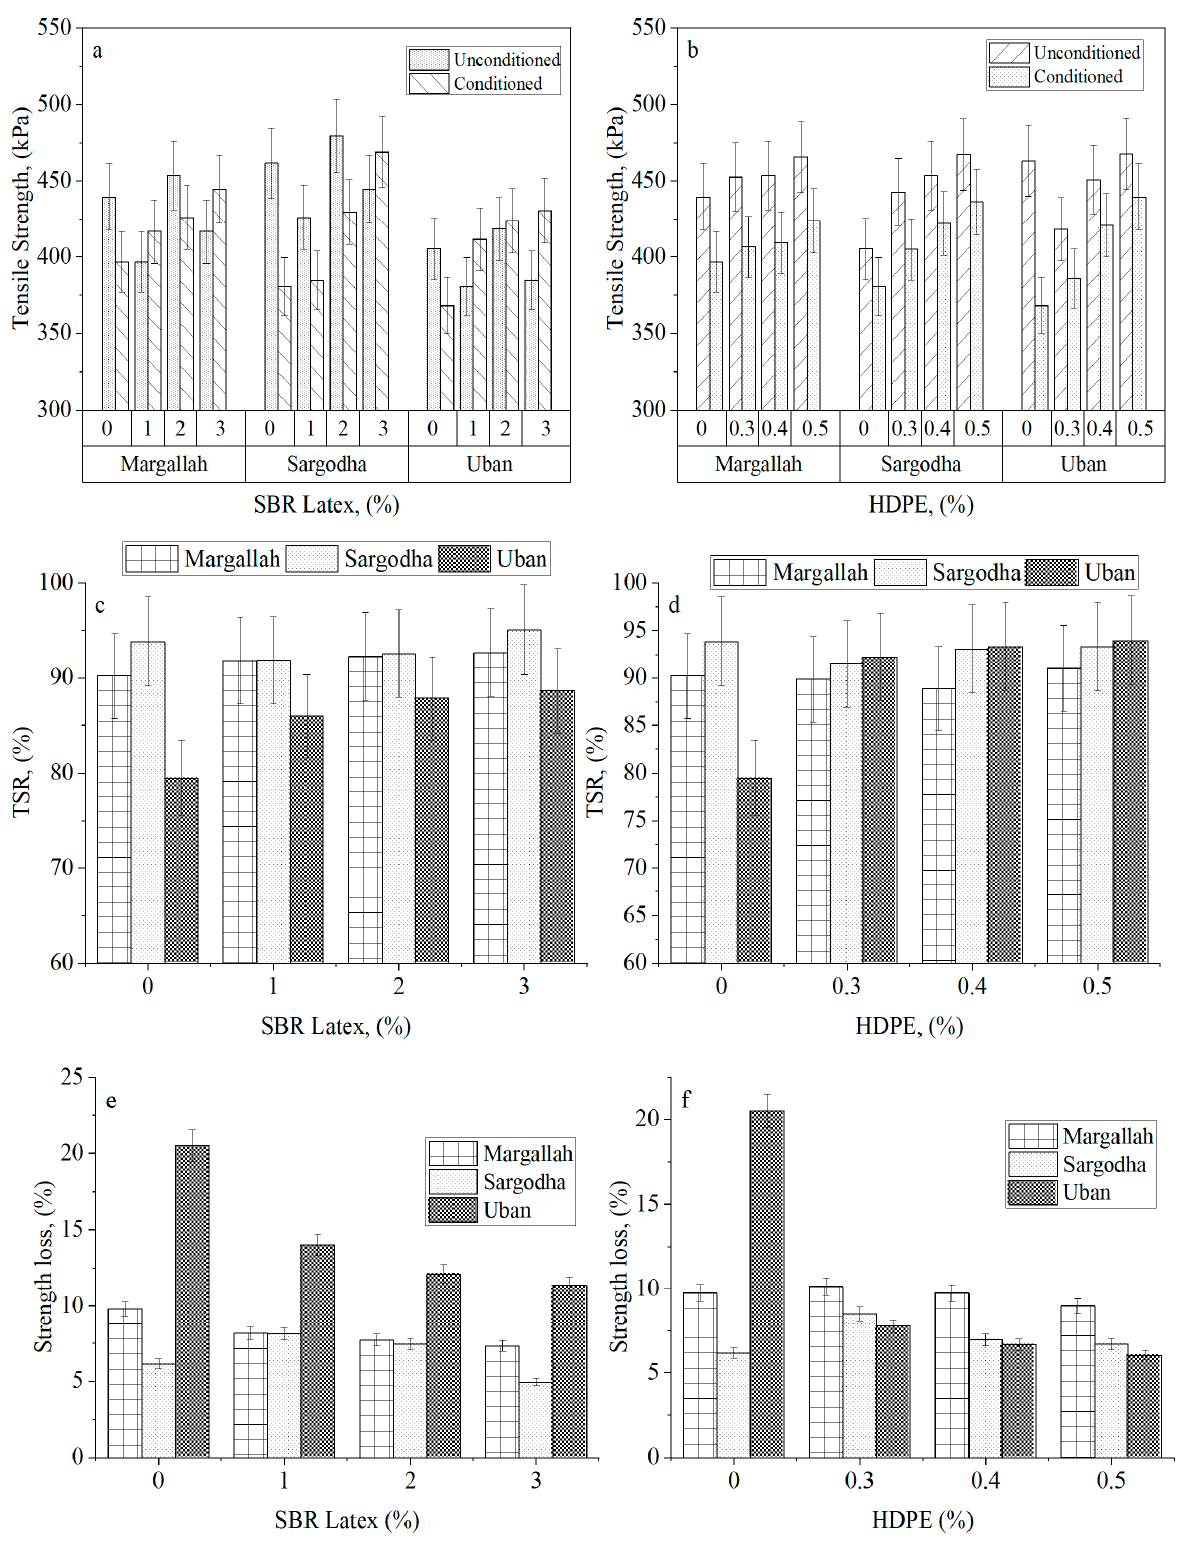
Figure 4. Results of ( a ) ITS test modified with SBR Latex, ( b ) ITS test modified with HDPE, ( c ) TSR of SBR Latex modified samples, ( d ) TSR of HDPE modified samples, ( e ) strength loss in SBR Latex modified samples, and ( f ) strength loss in HDPE modified